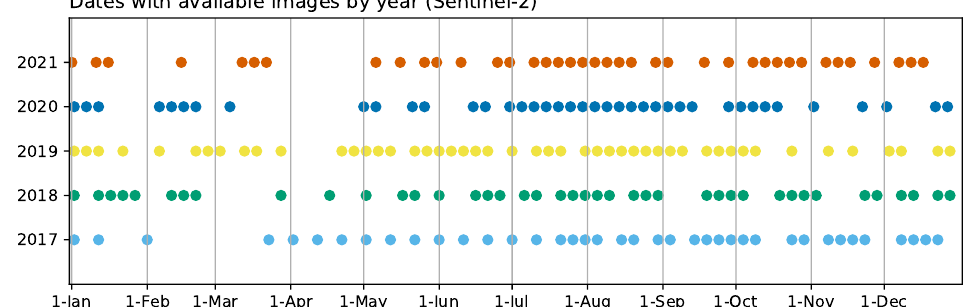
Figure 3. Partial or totally cloud-free Sentinel-2 images available covering the area during the time of the